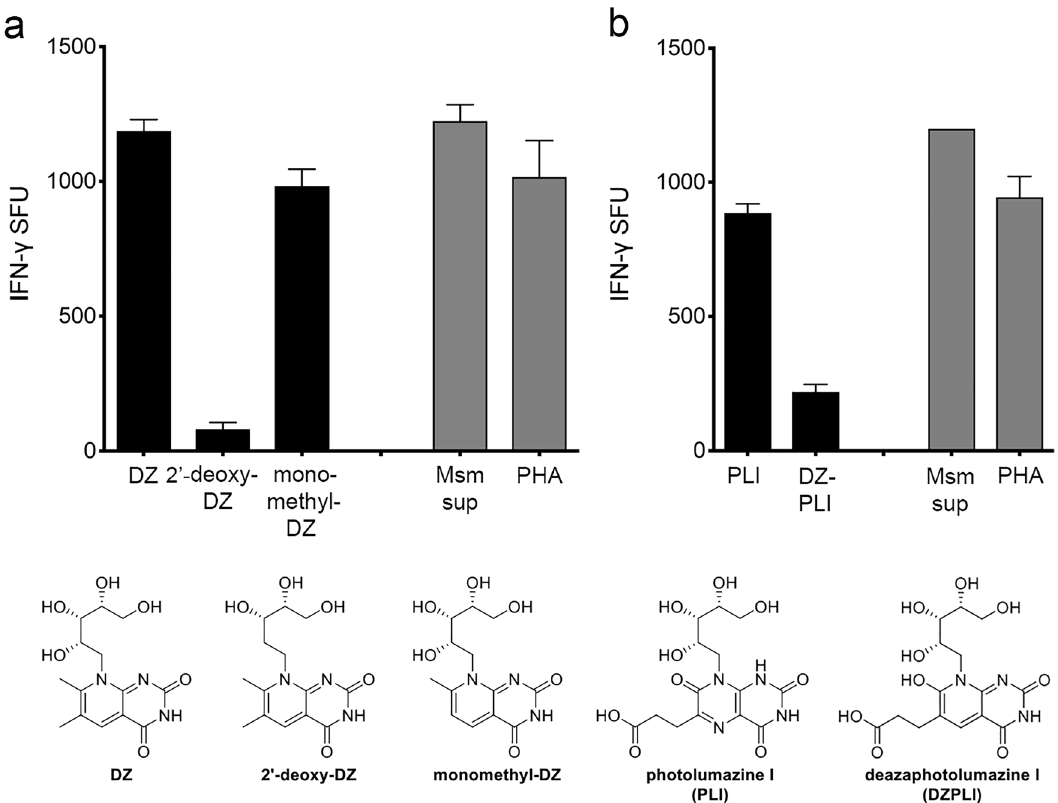
Figure 4. Impact of chemical modifications to DZ and PLI on MR1T cell responses. The IFN-γ response by 2 × 10 4 D481C7 MR1T cell clones was measured in an ELISPOT assay with either 1 × 10 4 ( a ) or 2 × 10 4 ( b ) DC pulsed with ( a ) DZ, 2 ′ -deoxy-DZ, or monomethyl-DZ at 100 μM, and ( b ) PLI or DZ-PLI at 50 μM as antigen presenting cells. PHA and supernatant from M. smegmatis were used as described as positive controls for all assays. Error bars indicate the mean and standard deviation of technical replicates. Data shown are representative of 3 independent